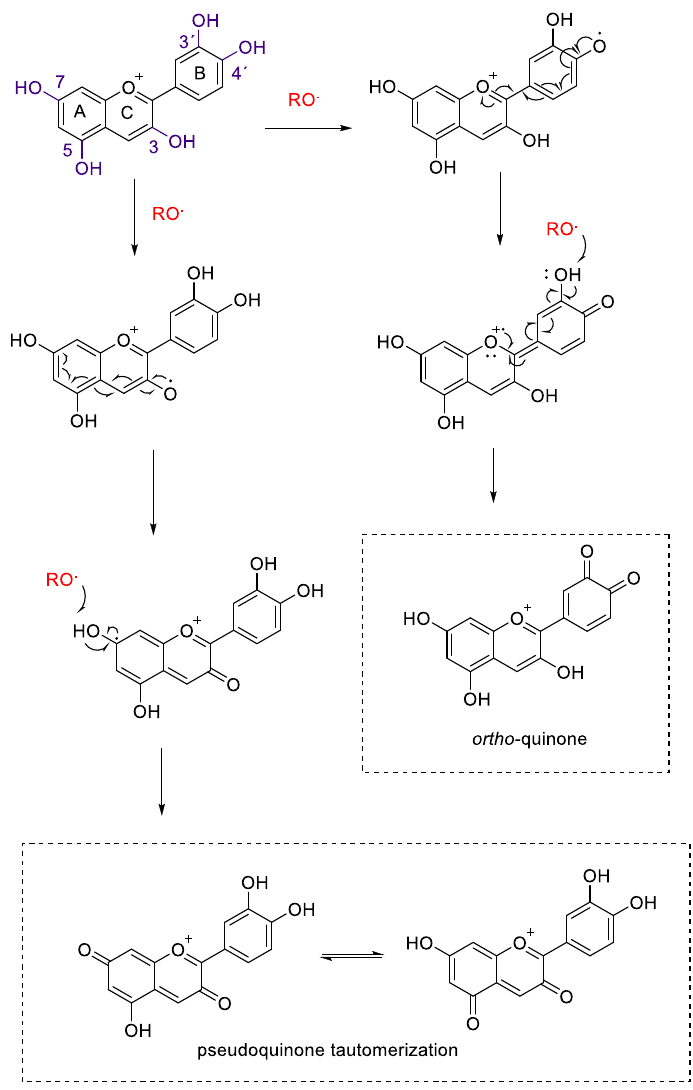
Figure 5. Cyanidin antioxidant scavenging mechanisms against a generic radical oxidant (RO • ). Radical attack on position 3 ( left ) and 4´ ( right ) are shown with the respective electron delocalization and resonance structures.